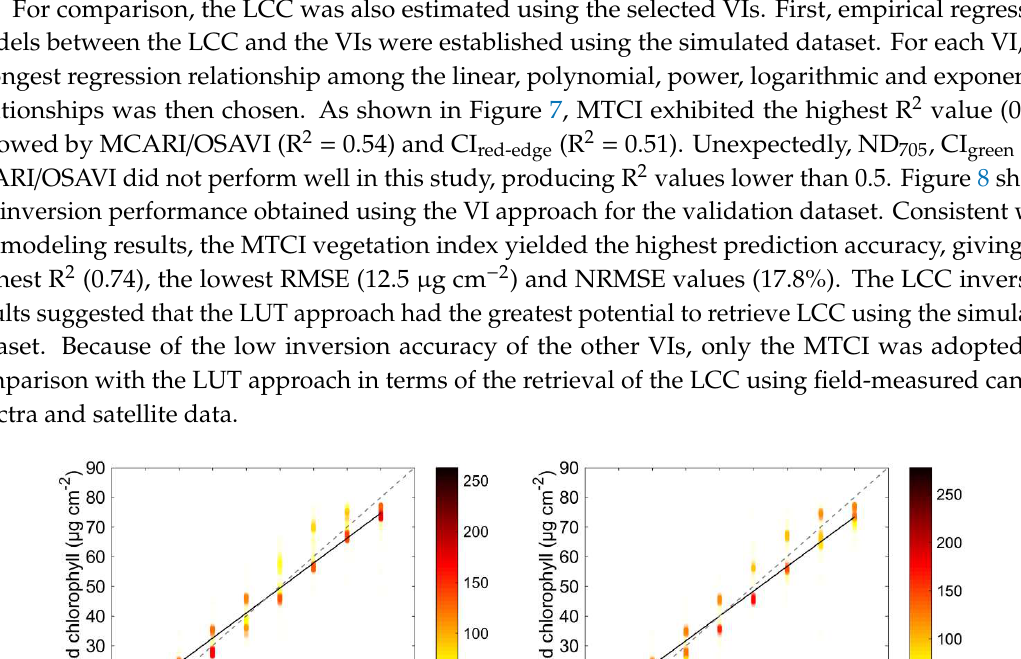
Figure 7. Relationships obtained between LCC and the indices MTCI, ND 705 , CI red-edge , CI green TCARI/OSAVI and MCARI/OSAVI calculated from the simulated dataset.